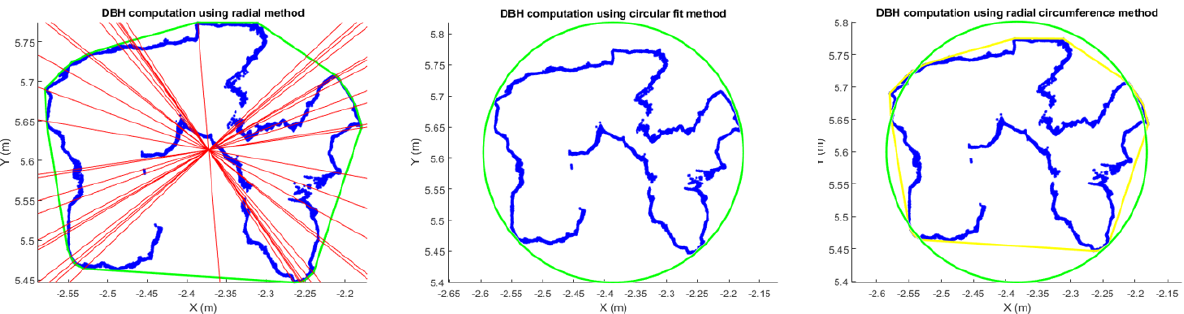
Figure 3 . Illustration of the different methods for DBH computation using the cross-section of “Tree 01” at a 1.3 m height. The Nikon Z50 point cloud was used for this illustration.